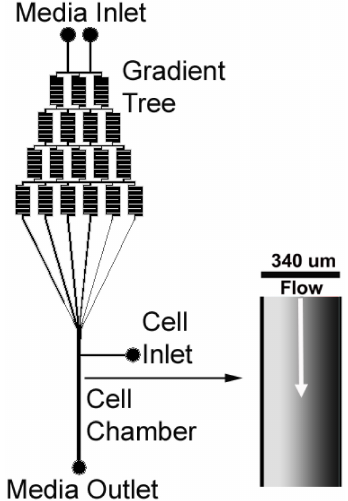
Figure 1. Microfluidic gradient generating chamber